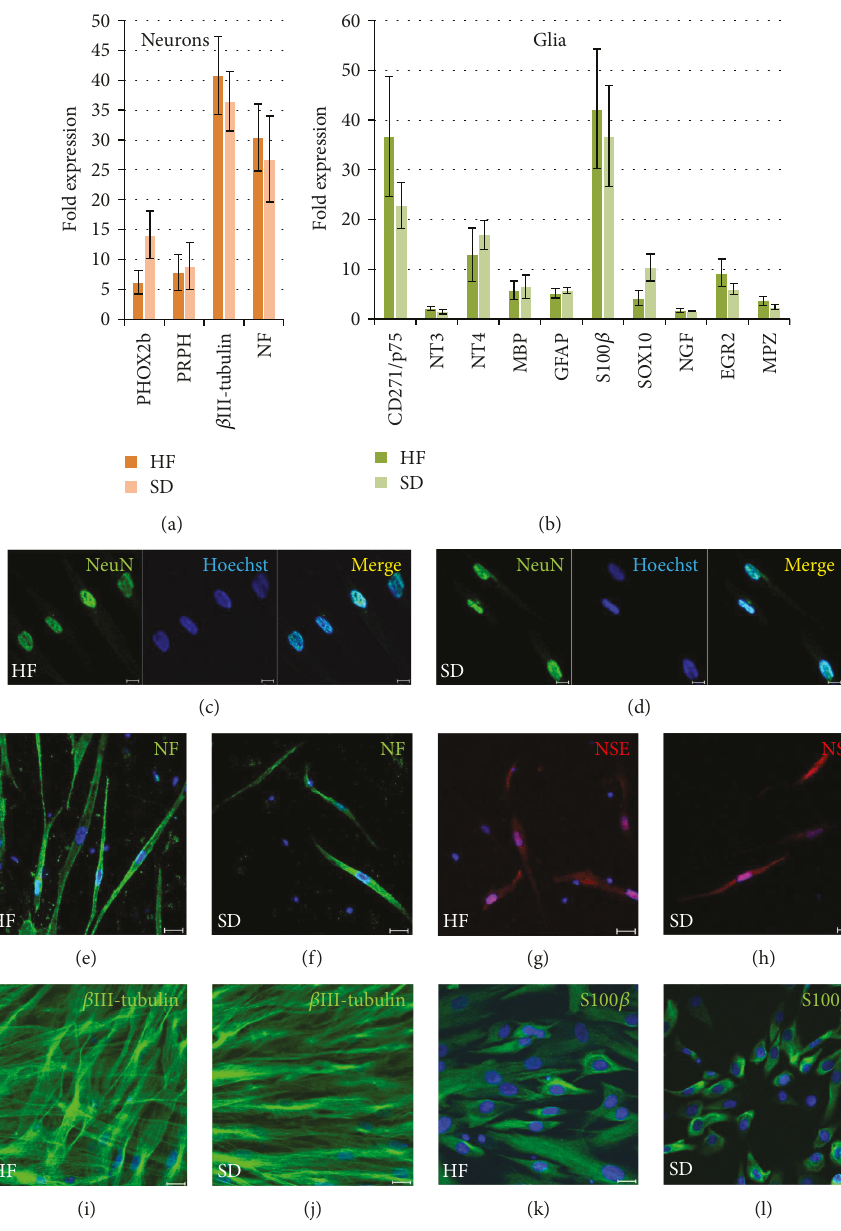
Figure 10: Neuronal and glial di ff erentiation of HF NCSCs and SD NCSCs. mRNA expression levels of neuronal (a) and glial (b) markers; qPCR analysis. The expression of all target genes was normalised to TBP gene expression levels and then to the undi ff erentiated control cells. The HF NCSC and SD NCSC cultures from fi ve donors were analysed. (c – j) Immunocytochemical analysis of neuronal and glial (Schwann cells). (k, l) Marker expression by HF NCSCs (c, e, g, i, k) and SD NCSCs (d, f, h, j, l). (c, d) NeuN (green); (e, f) neuro fi lament (NF; green); (g, h) neuron-speci fi c enolase (NSE; red); (i, j) β III-tubulin (green); (k, l) S100 β (green). The nuclei were stained with Hoechst 33342 dye; confocal microscopy. (c, d) Scale bar: 10 μ m. (e – l) Scale bar: 20 μ